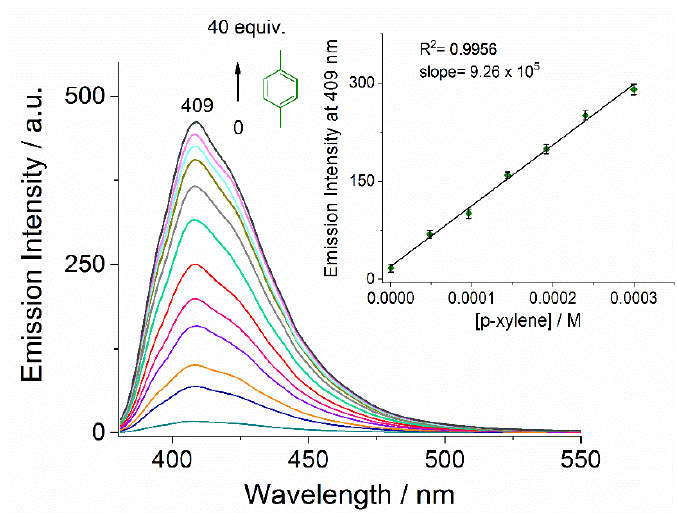
Figure 10. Changes in the emission spectra (λ ex = 330 nm) of acetonitrile suspension of 1 upon addition of increasing amounts of p-xylene (0–300 µM). The inset shows the calibration curve with a linear fit at λ em = 409 nm (average of triplicate experiments).